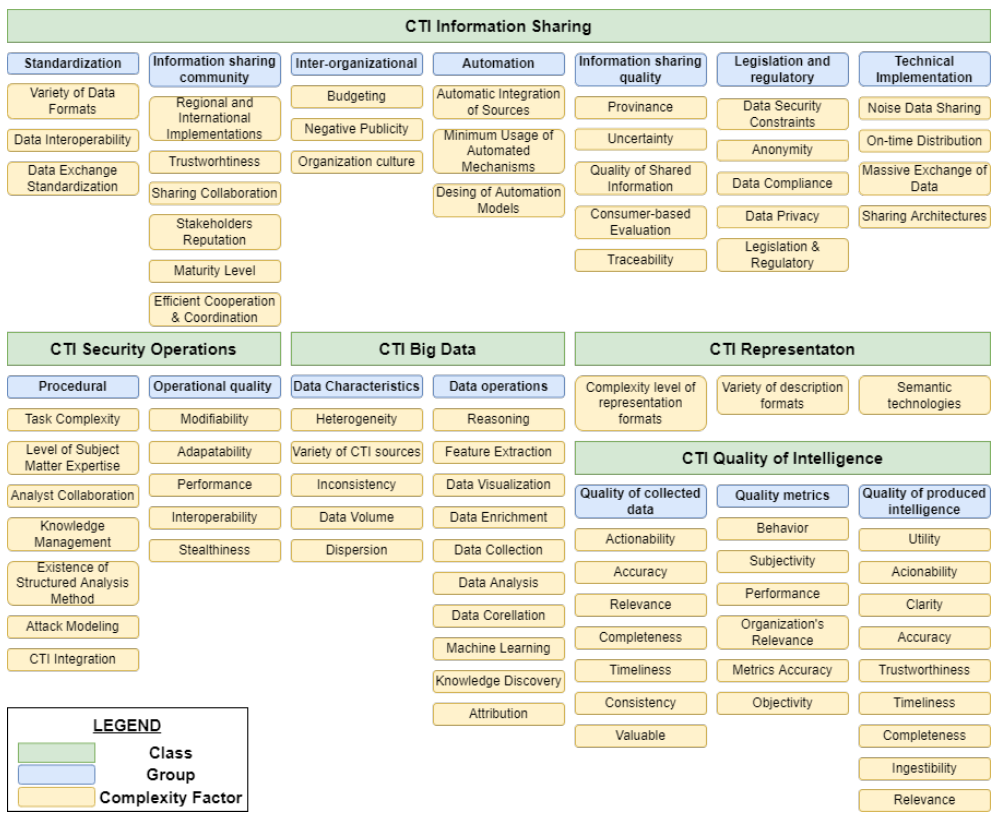
Figure 3. CTI Complexity Factors and their